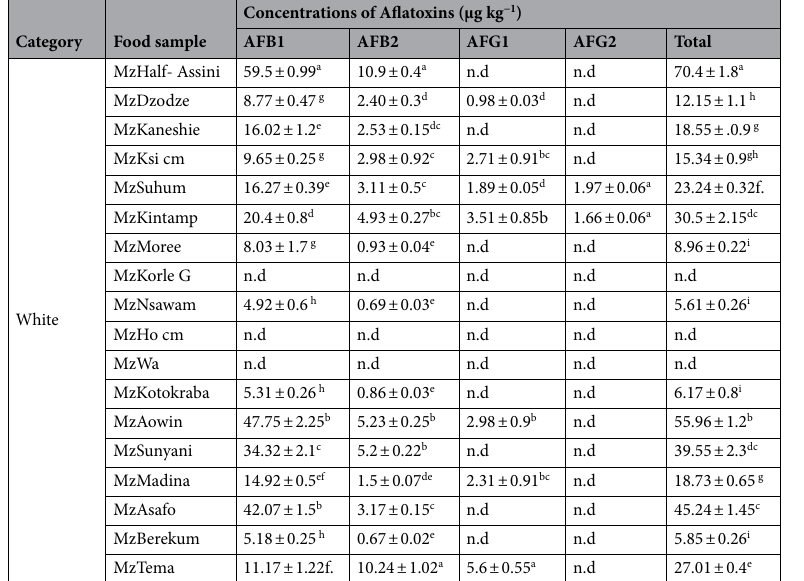
Table 3. Concentration of aflatoxin types in different maize samples from different locations of Ghana. Mean ± Standard Deviation that do not share a letter are significantly different (p > 0.05). n.d not detected.